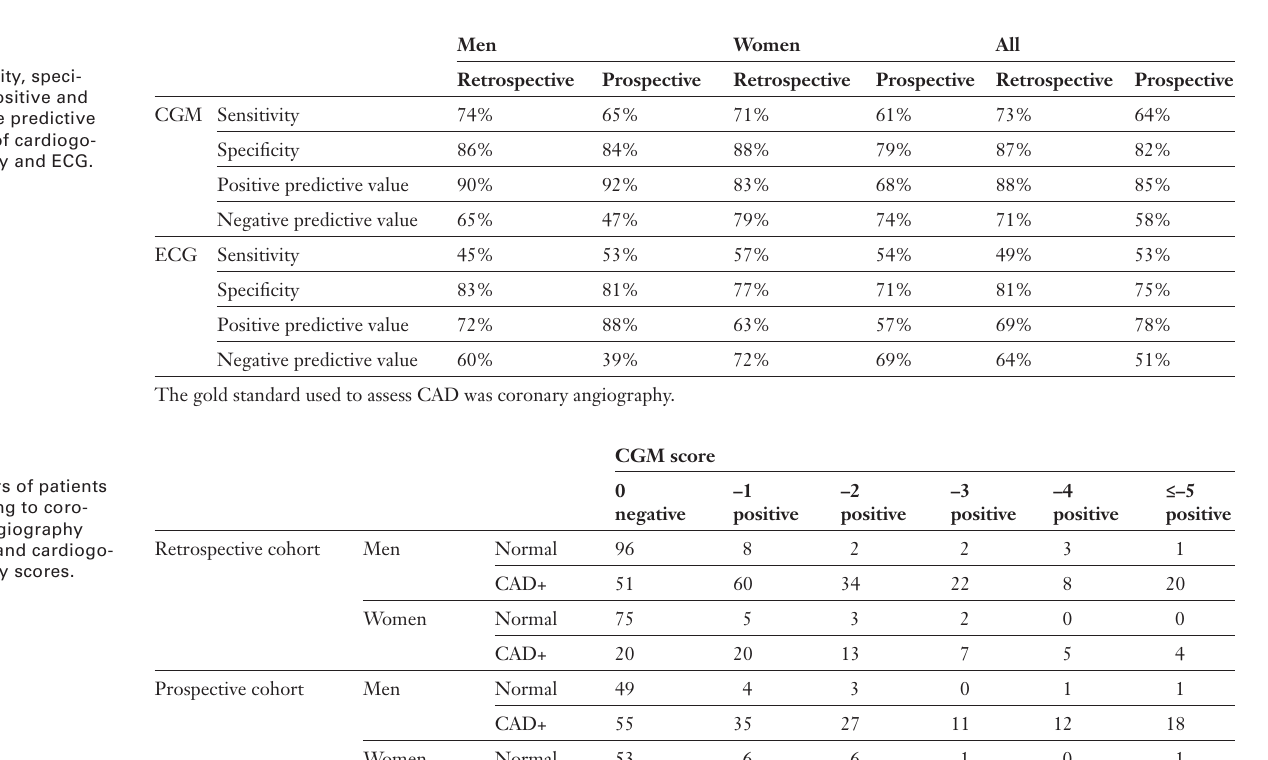
Sensitivity, speci- ficity, positive and negative predictive values of cardiogo- niometry and ECG.